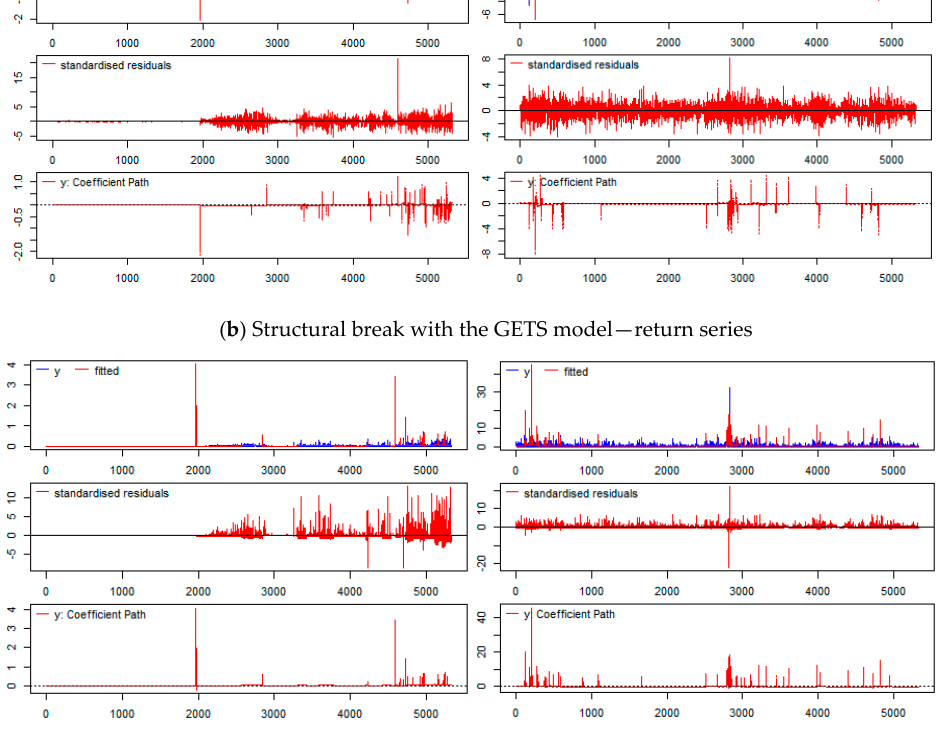
Table 2. Unit root test.